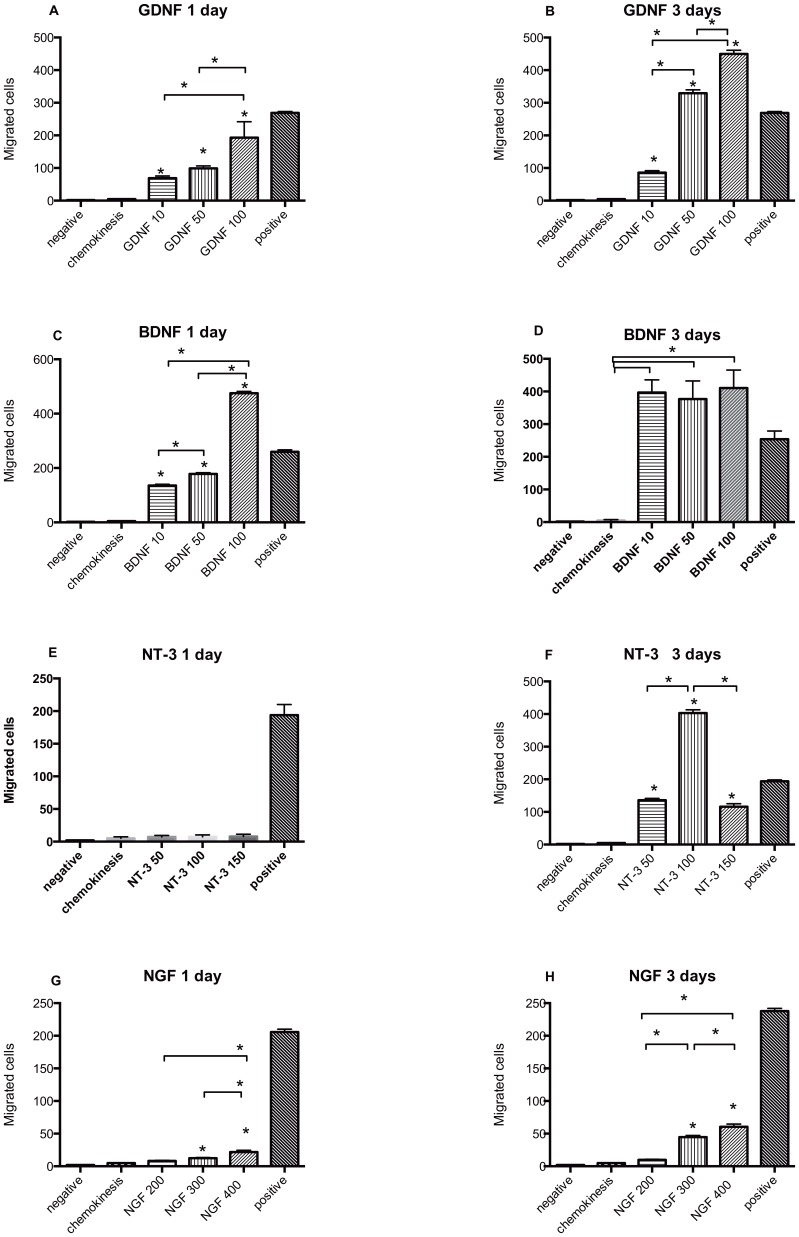
Migrated MASC (Mean and SEM) under different conditions (y axis).Panel A and B: GDNF at 10, 50 and 100 ng/mL concentrations during 1 and 3 days, respectively. Panel C and D: BDNF at 10, 50 and 100 ng/mL concentrations during 1 and 3 days. Panel E and F: NT-3 at 50, 100 and 150 ng/mL during 1 and 3 days, respectively. Panel F and G: NGF at 200, 300 and 400 ng/mL during 1 and 3 days, respectively. Each panel includes negative control (no neurotrophins added), chemokinesis (random movement control) and positive control (10% FBS). Statistically significant differences between chemokinesis and specific concentrations of neurotrophin were noted with an asterisk (p<0.05). The bars over the groups show statistically significant differences between different neurotrophins’ concentrations.